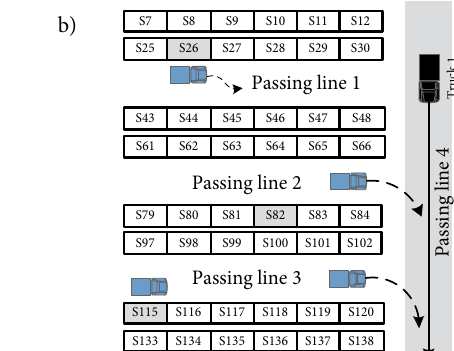
Figure 3. Interruptions happened in the travel